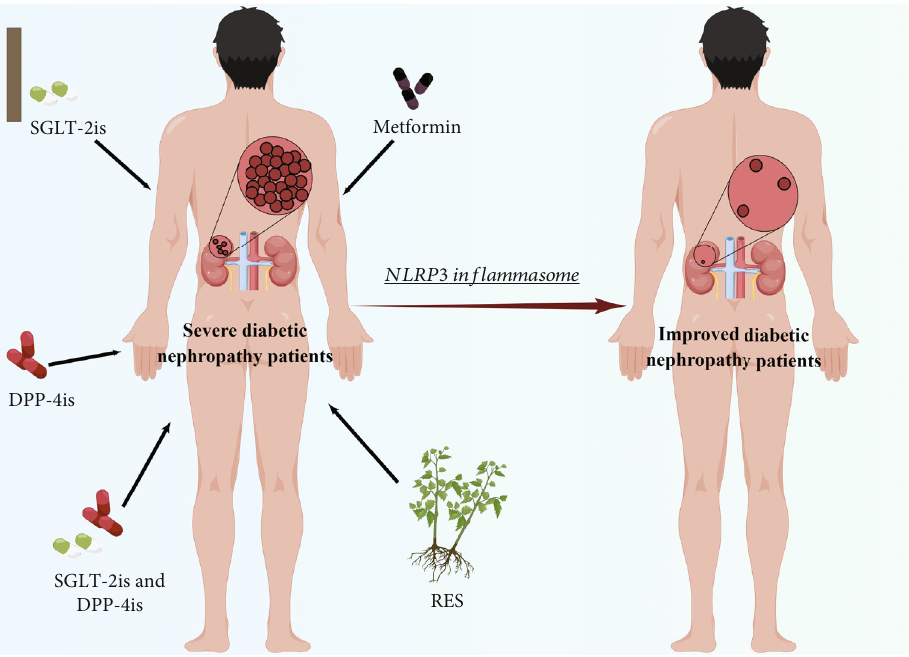
Figure 3: Clinical agents targeting NLRP3 in fl ammasomes for the treatment of diabetic